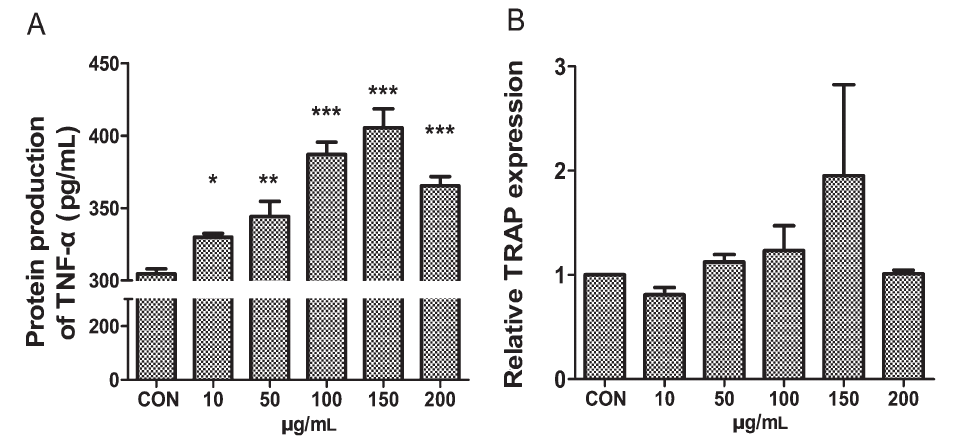
Figure 1. Expression of TNF- a and TRAP. A , ELISA showed the protein levels of TNF- a . RAW 264.7 cells were pretreated with titanium particles at different concentrations for 1 day. Data are reported as means±SD. *P , 0.05; **P , 0.001; ***P , 0.0001 (one-way ANOVA). B , Expression of the TRAP gene. The RAW 264.7 cells were pretreated with 30 ng/mL RANKL for 1 h and then treated with different concentrations of titanium particles for 5 days. CON: